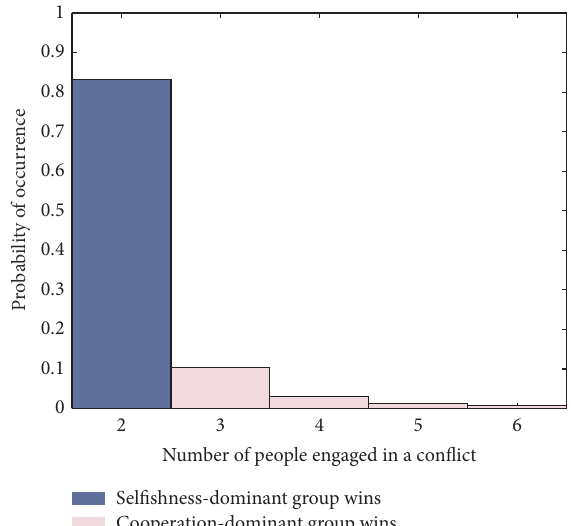
Figure 1: Illustration of probability of occurrence of a conflict involving 𝑥 persons and its consequence: conflicts are generated to be consistent with a power law, and their consequences are classified according to their size, where 𝑘 𝑐 = 2 .